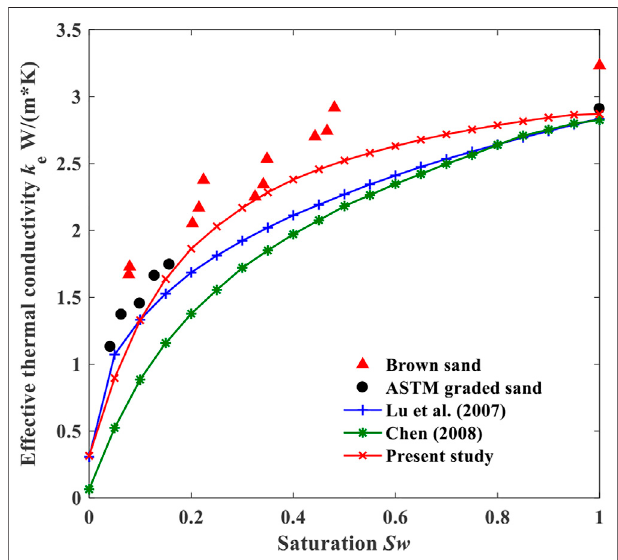
FIGURE 5 | Comparison of the present model with other